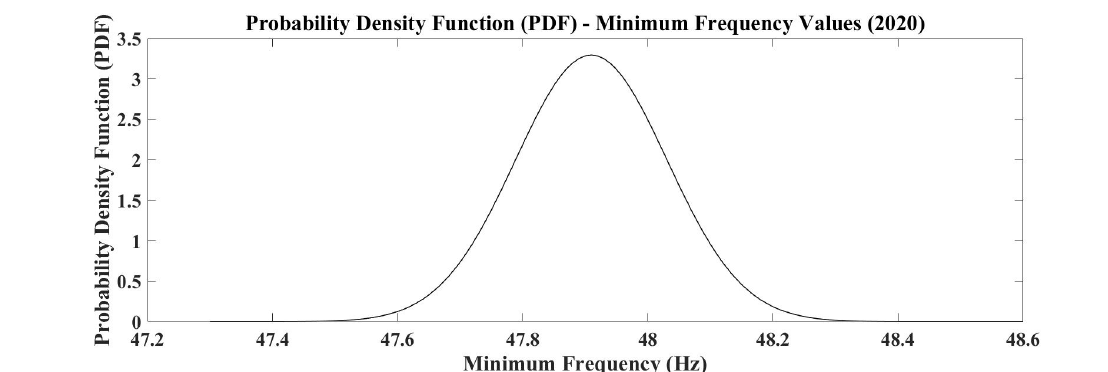
Figure 7: PDF curve of minimum frequency for year